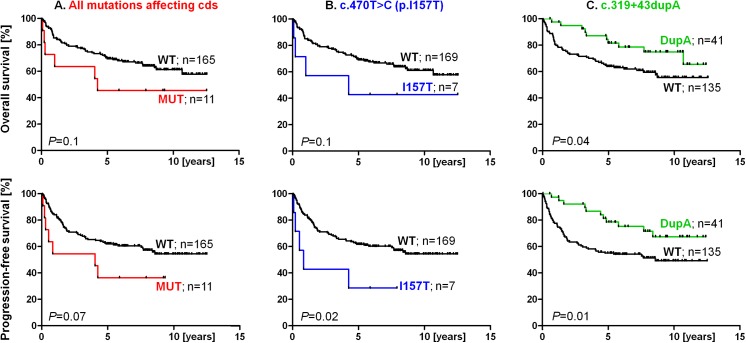
Overall survival (OS; upper panels) and progression-free survival (PFS; lower panels) in DLBCL patients.Panels show: A. the influence of all alterations affecting the CHK2 coding sequence (cds; HROS = 2.3; 95% CI 0.77–6.97 and HRPFS = 2.6; 95% CI 0.91–7.44); B. the influence of the I157T mutation (HROS = 2.9; 95% CI 0.70–12.00 and HRPFS = 5.2; 95% CI 1.25–22.16) and C. the influence of the c.319+43dupA variant (HROS = 0.6; 95% CI 0.32–0.97 and HRPFS = 0.5; 95% CI 0.32–0.86).